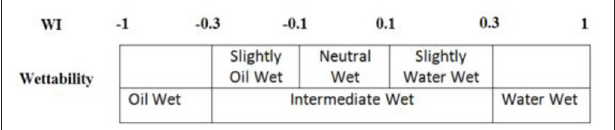
FIGURE 5 | Wettability classification based on Amott-Harvey wettability index